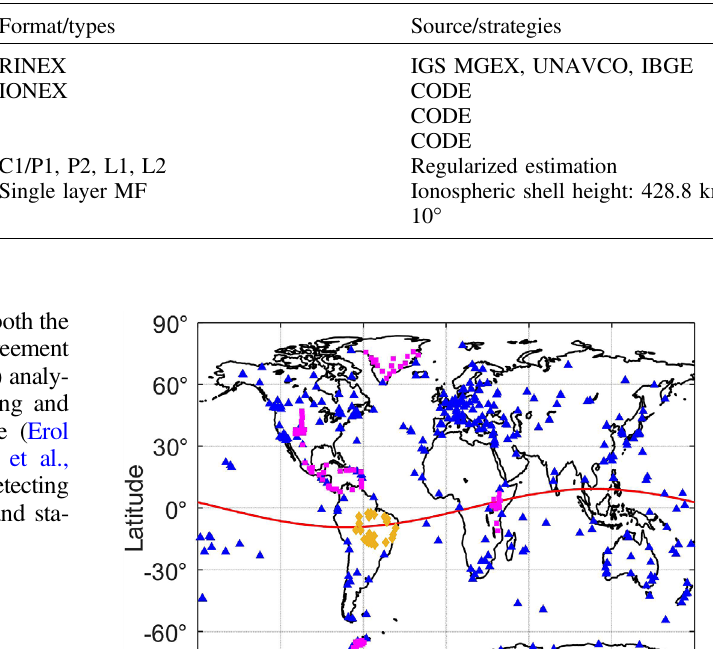
Table 1. Primary data sources and data processing strategies of IONOLAB-TEC.